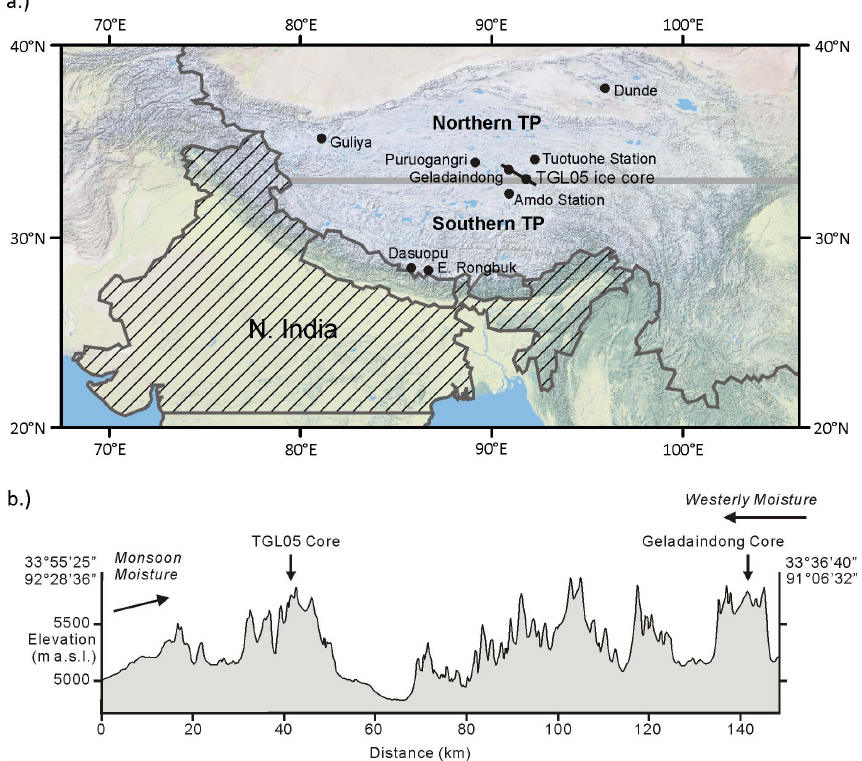
Fig. 1. (a) Ice core and meteorological station locations. Black line indicates elevation profile used for (b) . Approximate region of North India precipitation (Sontakke et al., 2008) shown with hatched fill, 33 ◦ N latitude shown as grey line. Borders are shown for reference only and are not meant to denote true political boundaries. (b) Elevation profile sketch from SE to NW within the Tanggula